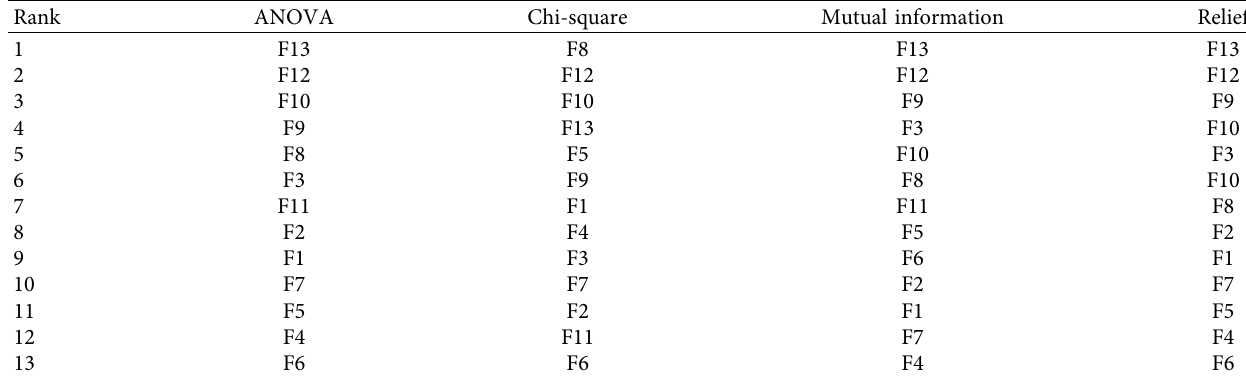
Table 2: Ranking order of features based on filter-based